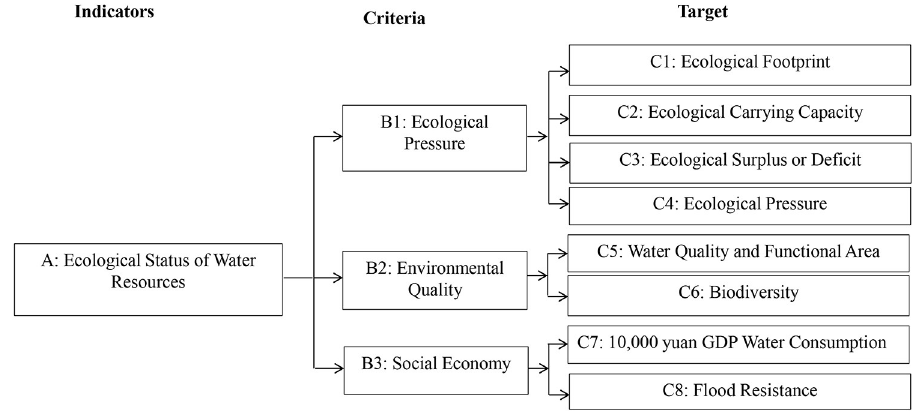
Fig 2. The assessment indicator system of water resources based on analytical hierarchical process.